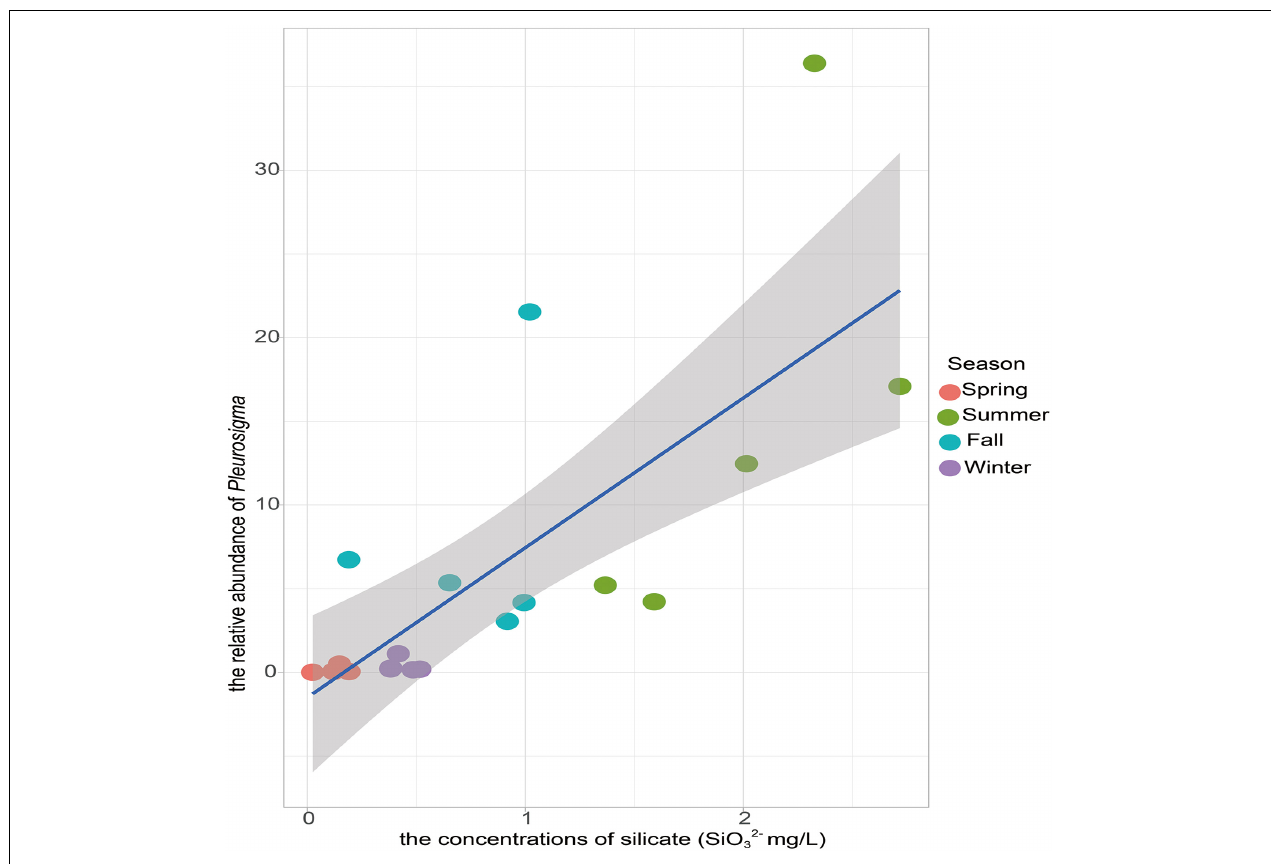
FIGURE 7 | The relationship between the relative abundance of the Pleurosigma and silicate concentration. Values of Pearson correlation coefficient (r) and probability ( P ) are provided. Blue lines indicate ordinary least squares linear regression across all samples.